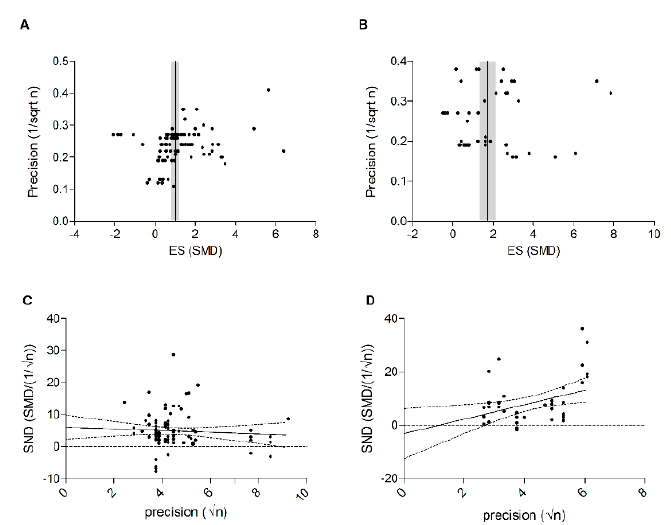
Figure 11. The funnel plots of studies which were included in the meta-analysis of ( A ) vision-based behavioral assays and ( B ) the b-wave amplitude. Publication bias was also assessed by Egger’s regression test, which is based on plotting the standardized normalized di ff erence (SND) on the y-axis and the precision (the square-root of the number of animals in an experimental group) on the x-axis in a funnel plot ( C , D ). Indication for publication bias was found for the vision-based behavioral studies (Egger’s test, p -value = 0.003) and no indication for publication bias was found for the b-wave amplitude (Egger’s test, p -value =